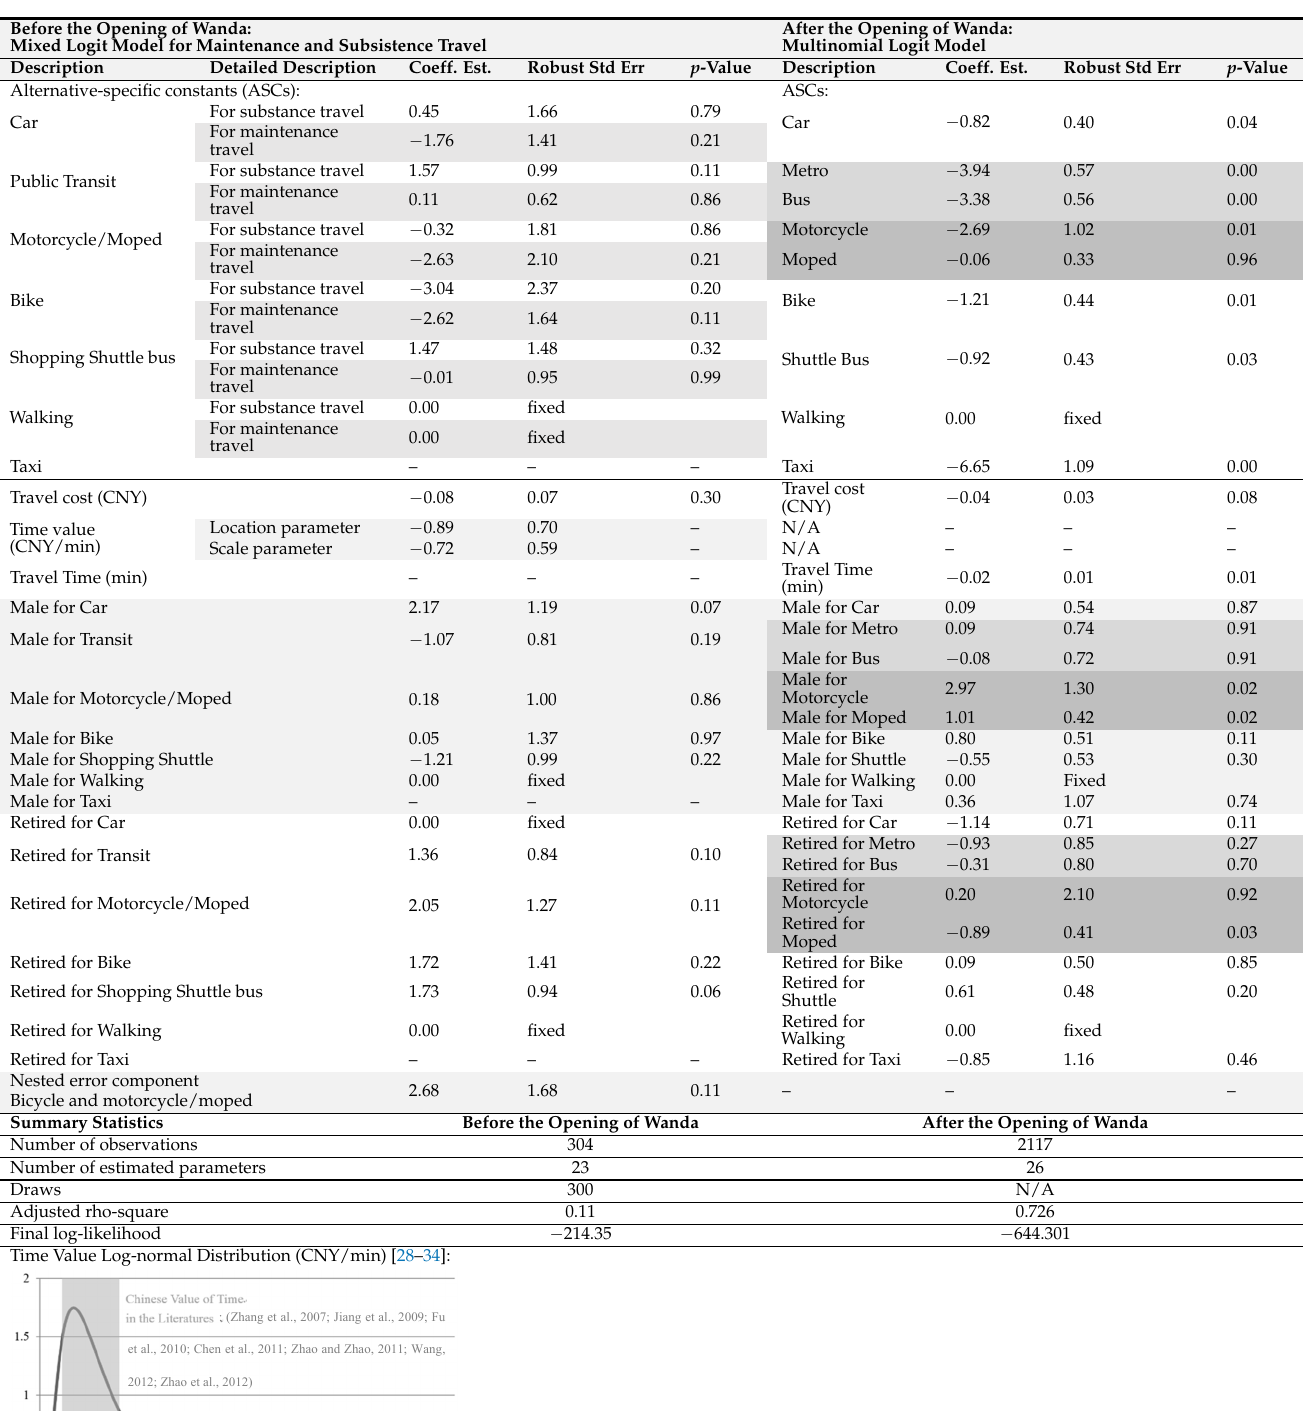
Table 2. Travel-mode choice logit models before and after the opening of Wanda (male and retired are both treated as dummy variables. CNY means Chinese Yuan; at the time of the survey, 1 United States Dollar (USD) = 6.25